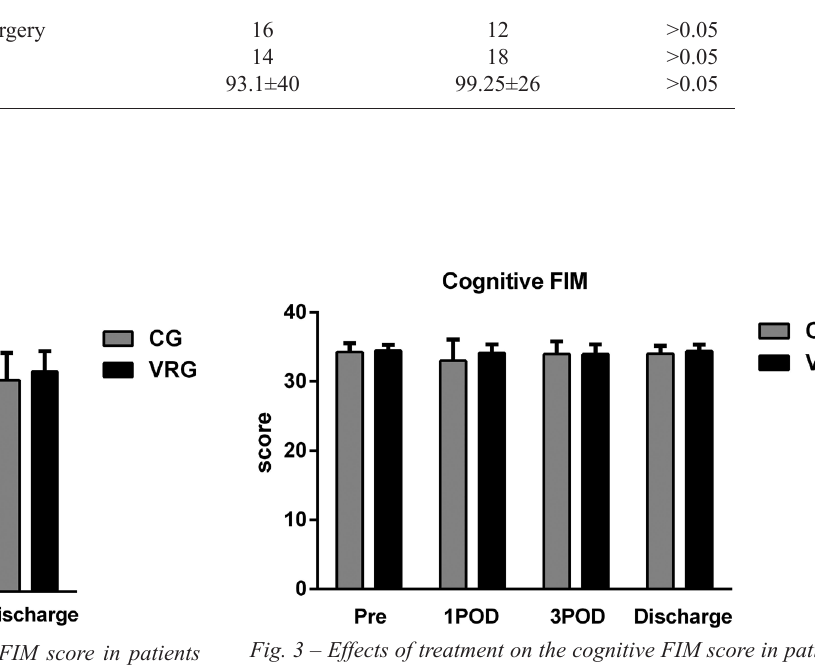
Fig. 2 – Effects of treatment on the motor FIM score in patients undergoing cardiac surgery. CG = Control Group; VRG = Virtual Reality Group; FIM = Functional Independence Measure, Pre - Pre operative; 1POD = first postoperative day; 3POD = third postoperative day; Discharge = Discharge day. Data were analyzed using two-way ANOVA (*VRG x CG at 1st PO, P< 0.05)